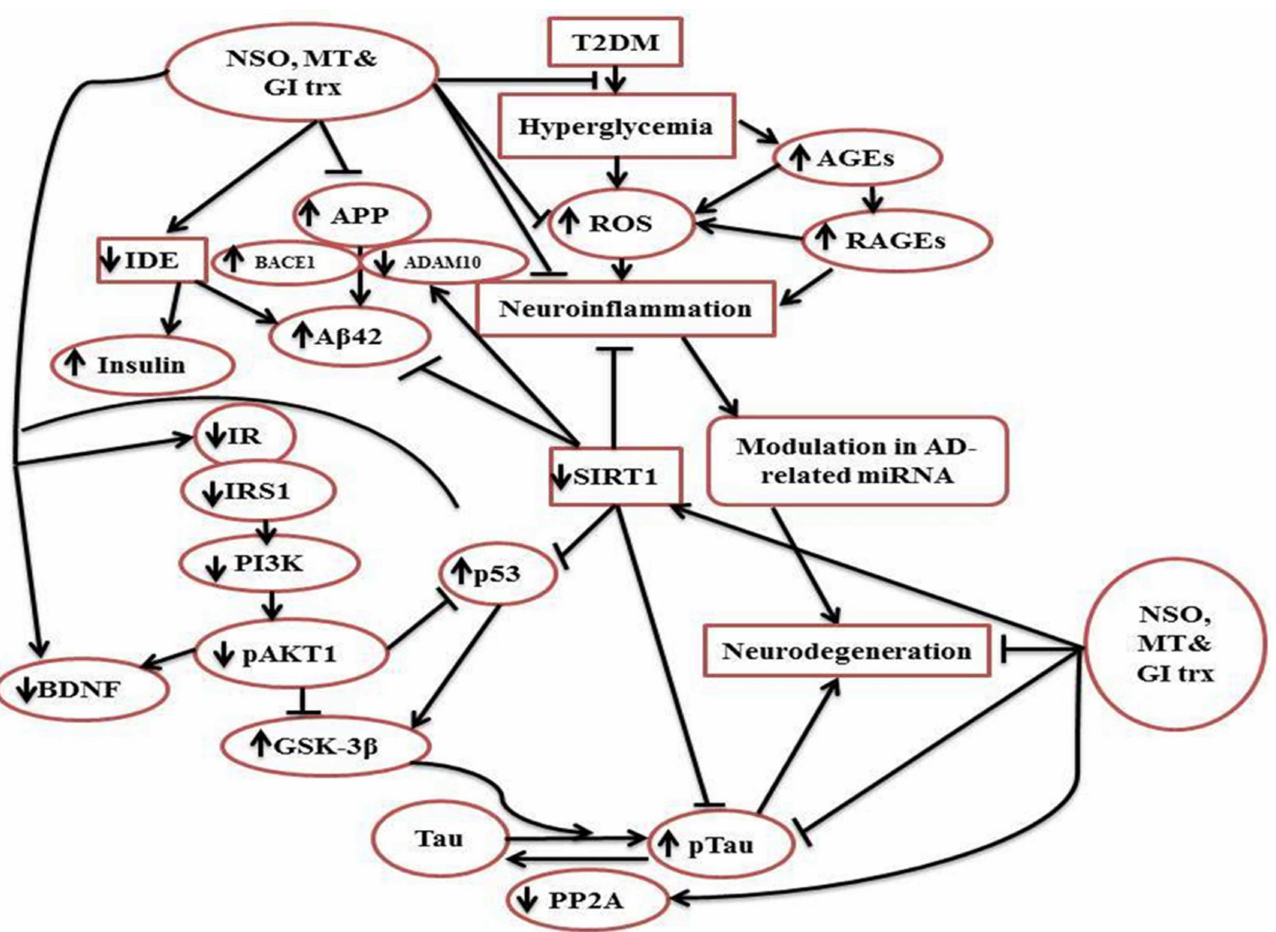
Fig 6. Schematic diagram for the effect of NSO combined with the anti-diabetic drugs MT and GI on brain insulin signaling in HFD/STZ- induced rats. This effect lowers the ameliorationof ROS-inducedT2DM and decreasesthe attenuation of the signalingmoleculesIR, IRS1, PI3K and AKT. This modifyingeffect results in Tau dephosphorylation, less neurodegenerationand modulationof AD-relatedmiRNA.